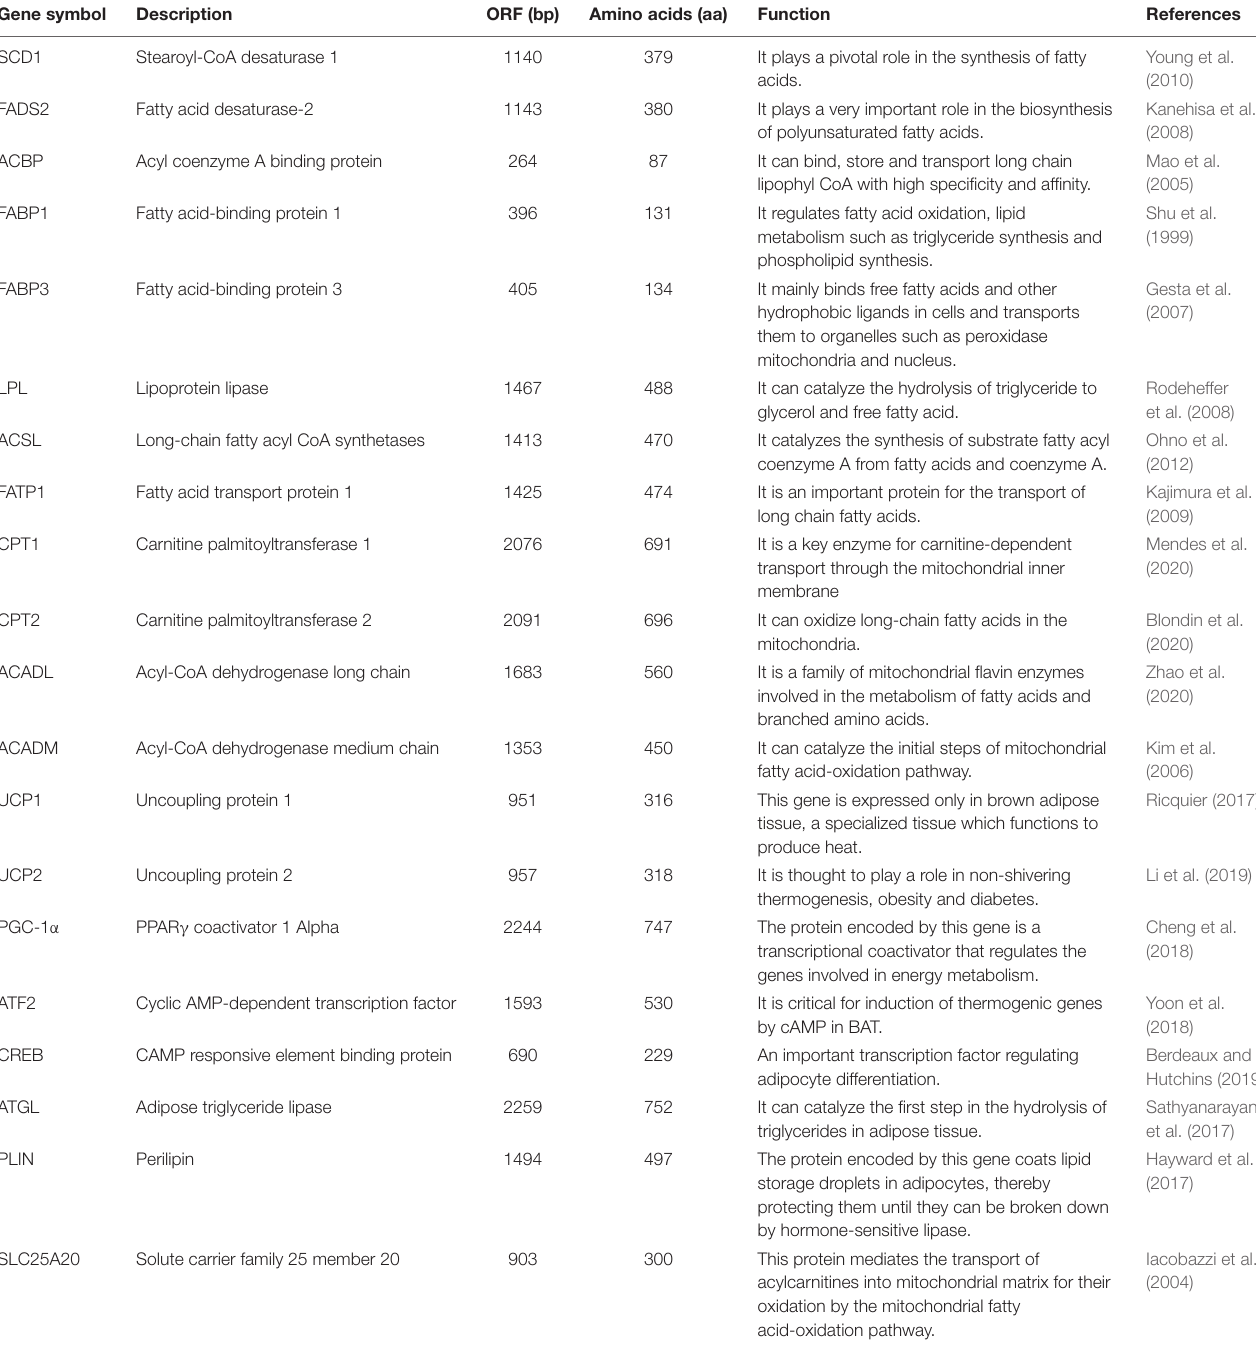
TABLE 1 | Identification of the molecule relative to thermogenesis and lipid metabolism in